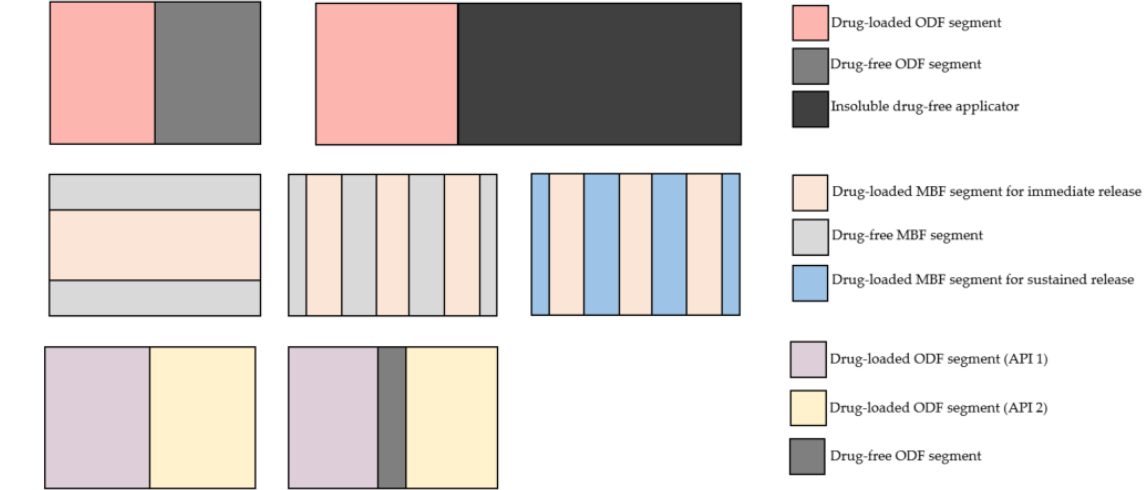
Figure 1. Conceptualization of different tandem films and their possible applications: ( a ) applicator films, ( b ) optimization of dissolution rate and ( c ) optimization of stability in the case of incompatible APIs.